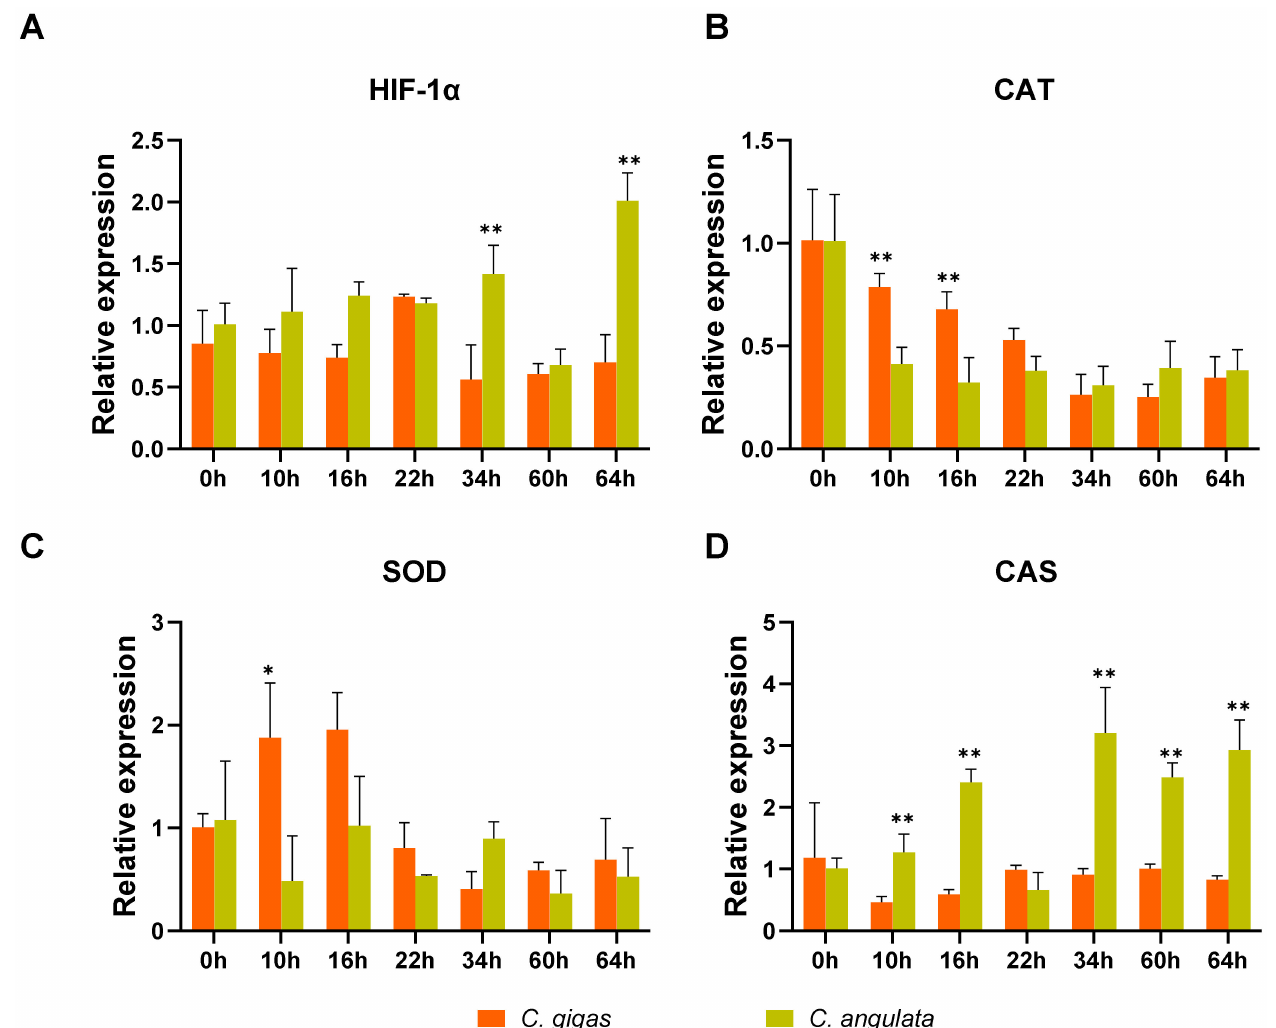
Figure 7. Effect of chronic heat stress on expression of ( A ) HIF-1 α , ( B ) CAT, ( C ) SOD, ( D ) CAS in gill of two oyster species. Values were expressed as mean ± S.E ( n = 3). Asterisks indicate statistical significance (* indicates p < 0.05 and ** indicates p < 0.01) (ANOVA). HIF-1 α , hypoxia inducible factor-1 α ; CAT, catalase; SOD, superoxide dismutase; CAS,